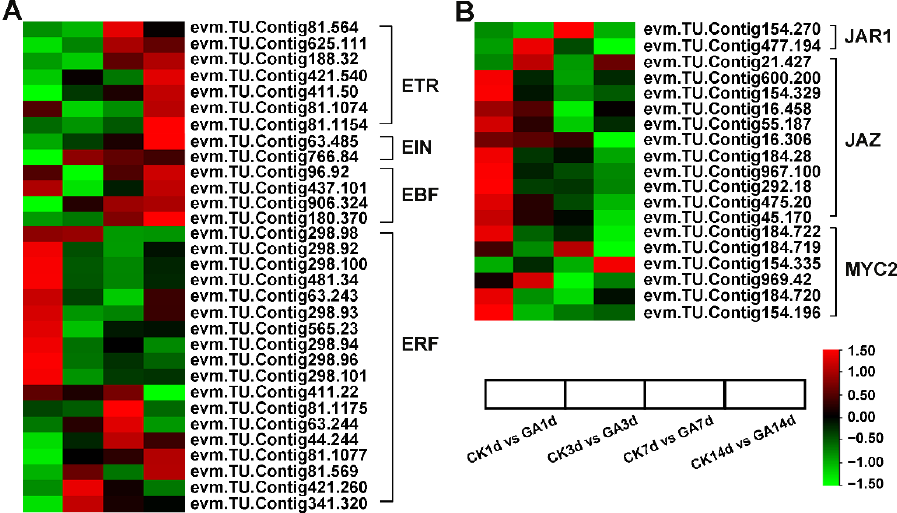
Figure 7. Effects of GA treatment on the other hormone signaling pathways. ( A ) RNA-seq data showed the DEGs of ethylene signaling. ( B ) RNA-seq data showed the DEGs of JA signaling. Data are shown with log2 (Fold Change) analysis. Heatmap of columns and rows represent samples and genes, respectively.